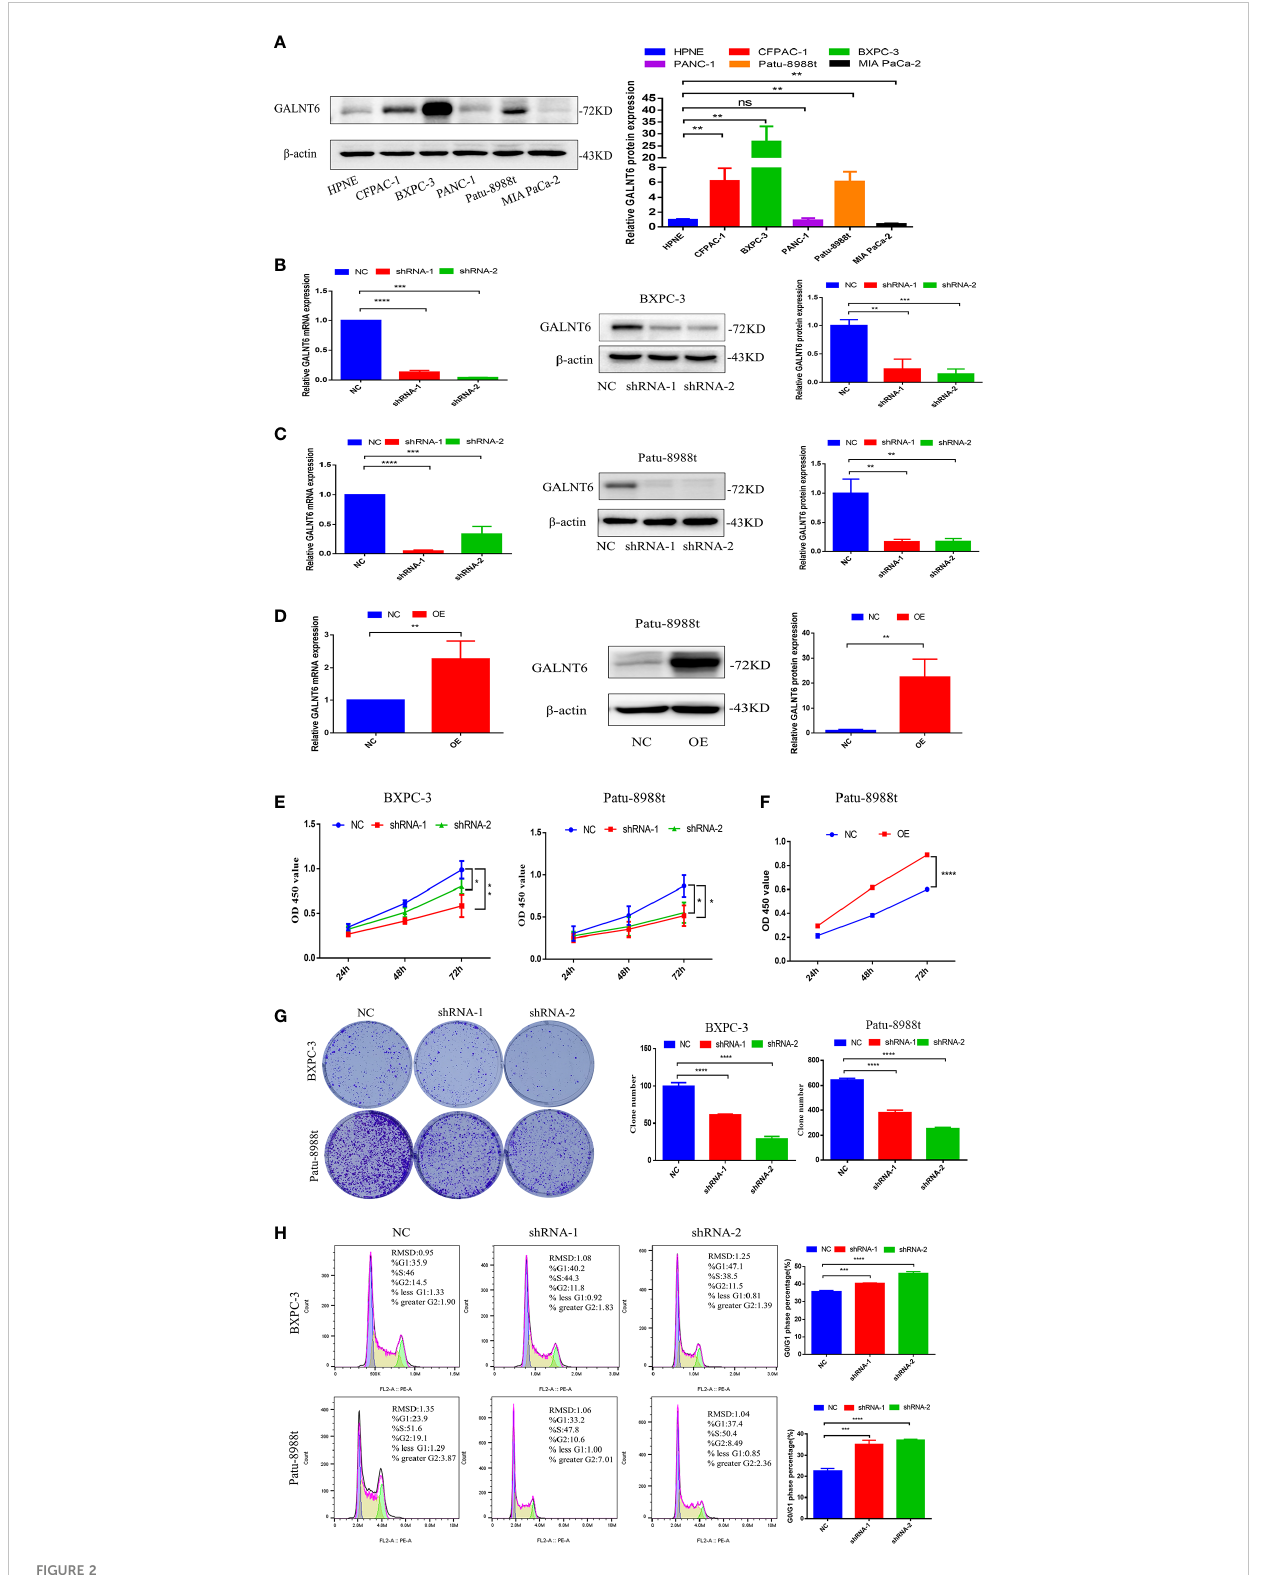
FIGURE 2 GALNT6 promotes the growth of PDAC cells. (A) Western blot was used to detect expression of GALNT6 in pancreatic cancer cell lines and pancreatic ductal cell. (B, C) The protein expression of GALNT6 was identi fi ed by western blot and the mRNA expression of shGALNT6 was identi fi ed by qRT-PCR. (D) The overexpression of GALNT6 in Patu-8988t cells was con fi rmed by western blot and qRT-PCR. (E, F) CCK8 was used to detect cell viability. (G) Plate cloning assay was used to detect cell proliferation. (H) Flow cytometry was applied to detect cell cycle. Each experiment was repeated at least three times independently, and the experimental data were expressed as mean standard deviation (X ± SD). ns, p >0.05; *p <0.05; **p <0.01; ***p <0.001; ****p